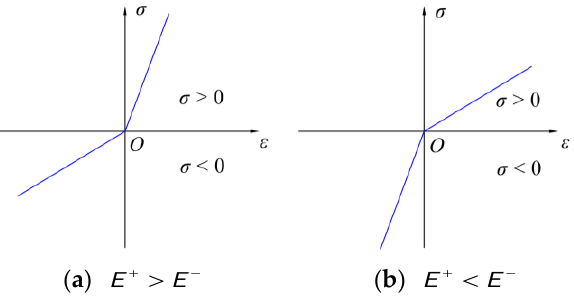
Figure 1. Bimodular materials model presented by Ambartsumyan.